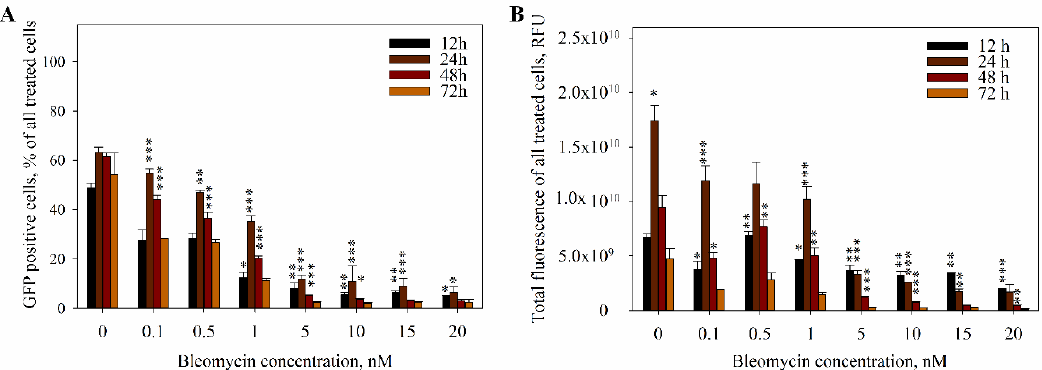
Figure 5. The dependence of electrotransfection efficiency ( A ) and total cell fluorescence ( B ) of all treated cells on the bleomycin concentration at various time points (12, 24, 48, and 72 h). The cells were electroporated with one high-voltage (1400 V/cm, 100 µs) electric pulse. Two-tailed Student’s t-test p values < 0.05 are marked with *, p < 0.01 is marked with **, and p < 0.001 is marked with ***.